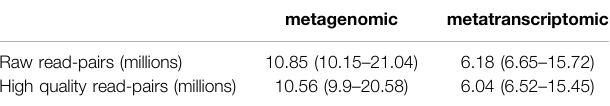
TABLE 2 | Median (minimum and maximum) of raw and high-quality million read- pairs in the 91 human fecal microbiome samples from the